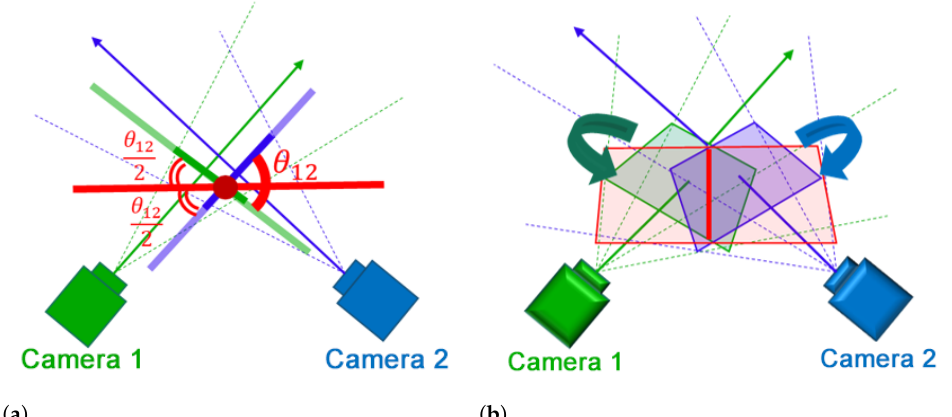
Figure 5. Constructing the expanded view using planar projection: ( a ) An abstract illustration of the intersection of planes and the angle between them, and ( b ) An illustration of the new projection plane shown in